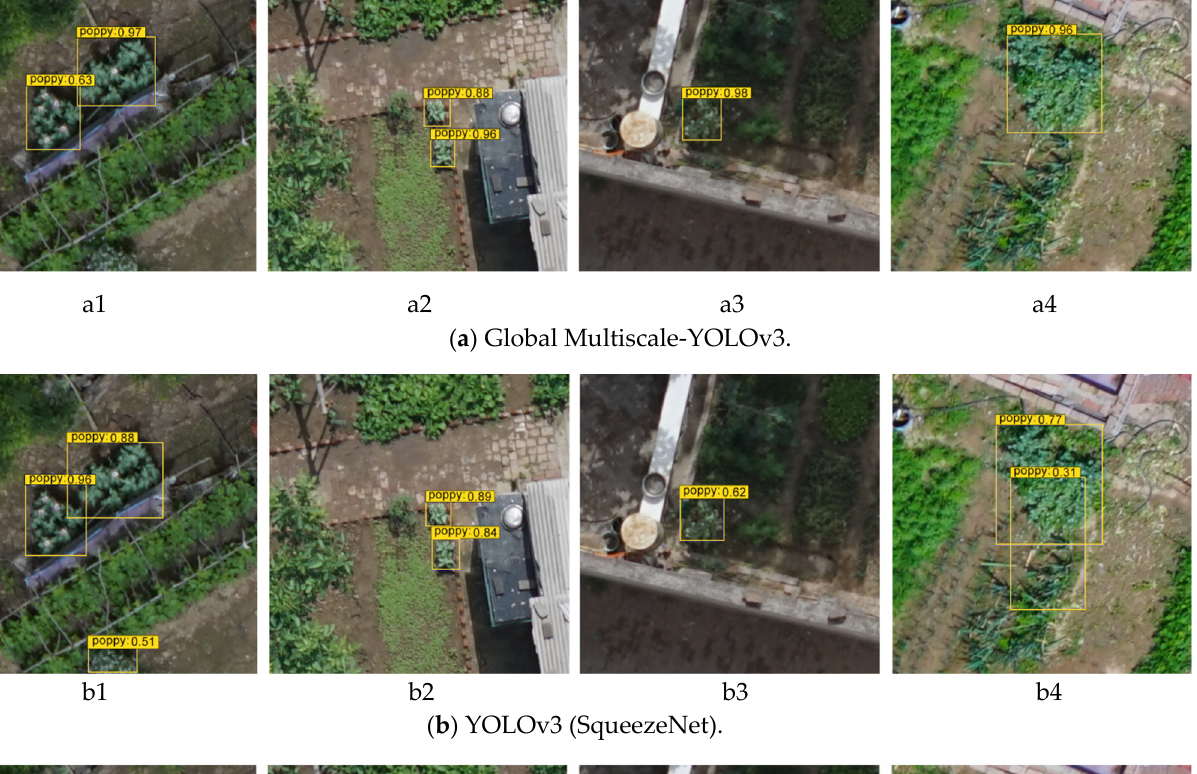
Figure 11. The relationship between mAP and detection time.